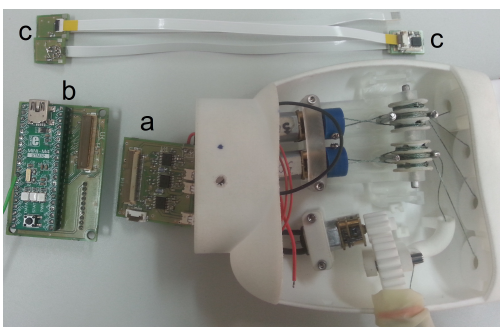
Figure 10. The home made miniaturized electronics. ( a ) The drivers PCB, composed of motor drivers and input for magnetic encoders ( b ) The control PCB composed of a STM32 ARM Cortex-M4 STM32 Microcontroller, and a X-bee communication (on the back of the board); ( c ) The daisy chain magnetic encoders boards.